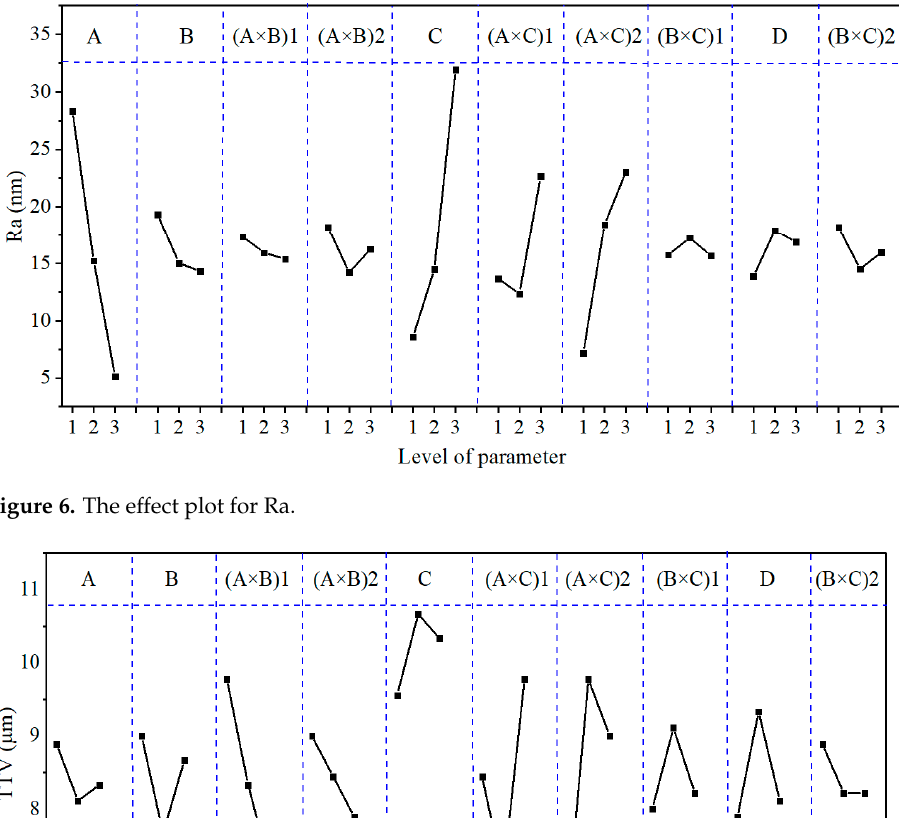
Figure 5. The effect plot for MRR m .